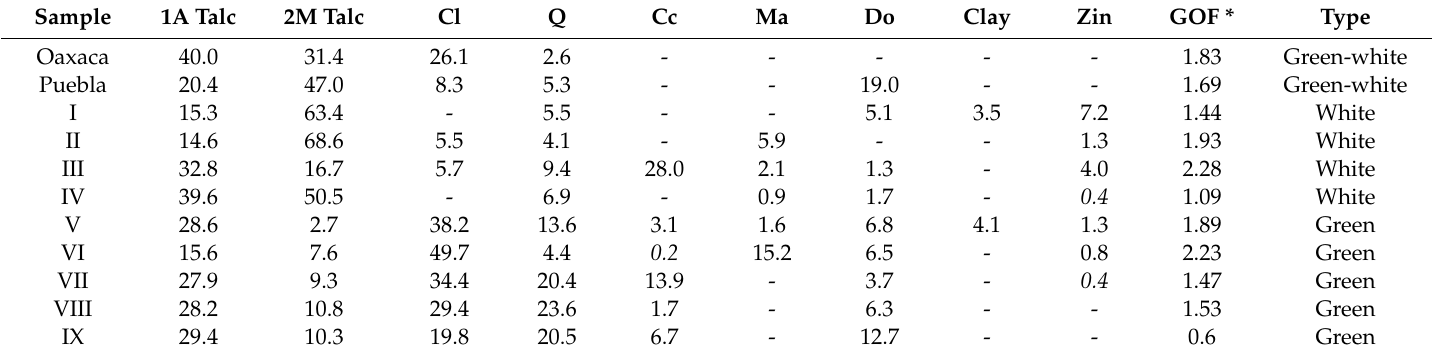
Table 2. Mineralogical composition determined by XRD and refinement by the Rietveld method. Sample